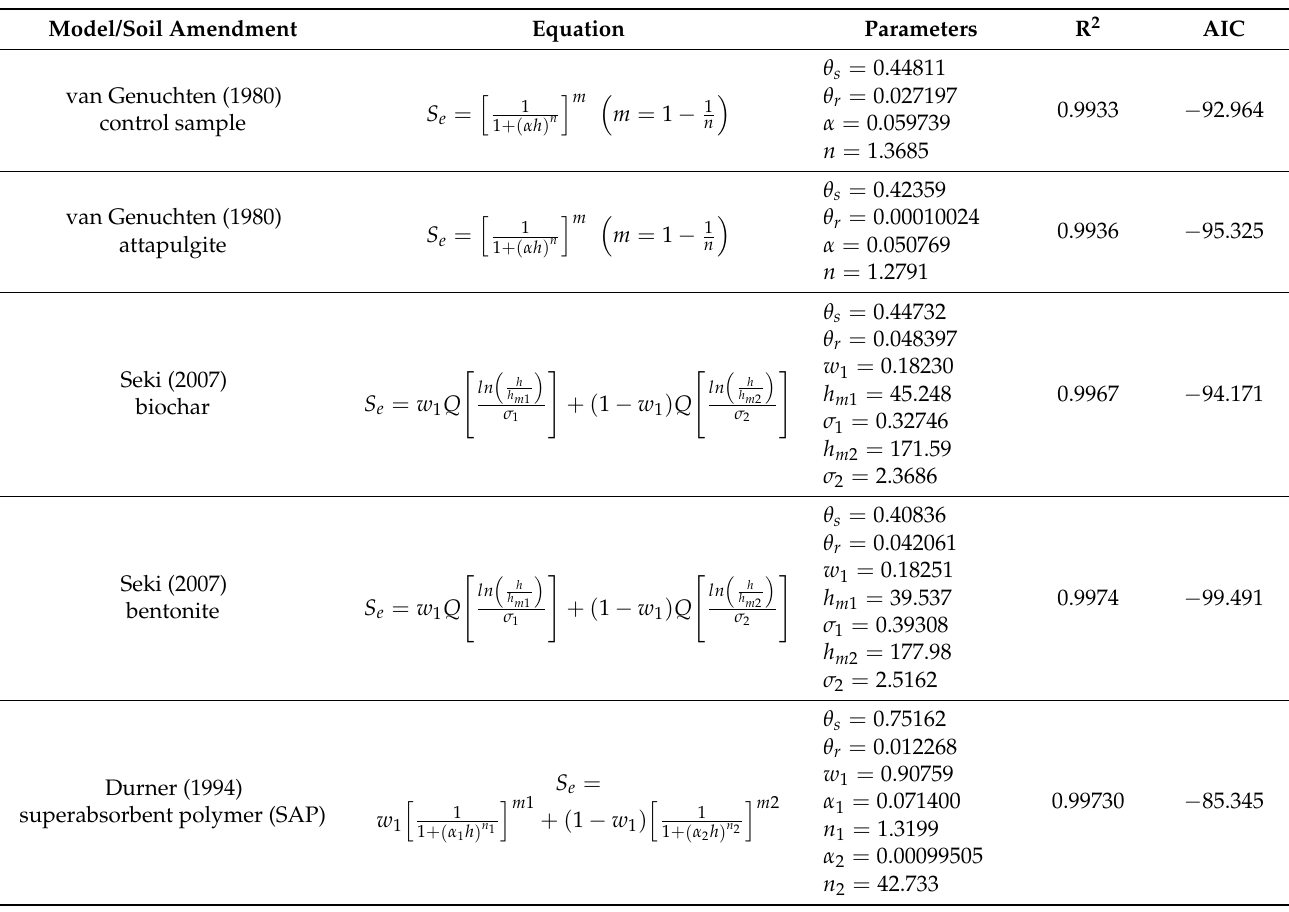
Table 1. Equations and specific model